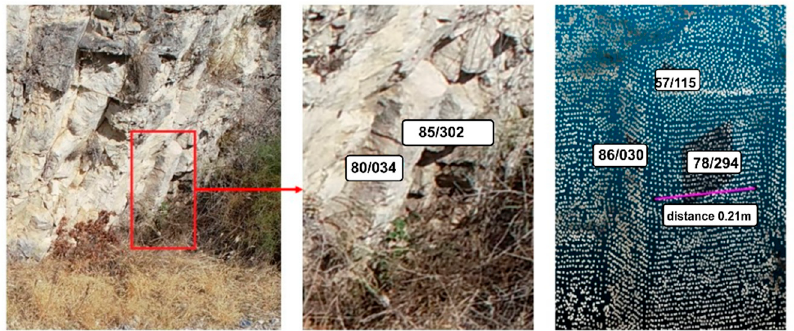
Figure 4. Validation of the structure from motion (SfM)-based developed point cloud through the comparison of the orientation of discontinuity sets defined based on geological compass and the generated 3D